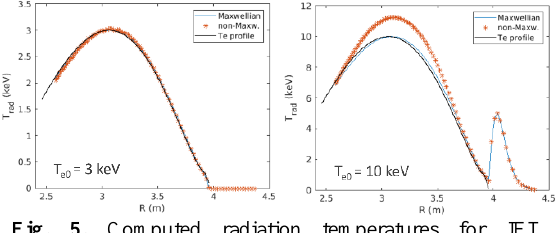
Fig. 5. Computed radiation temperatures for JET parameters and two different central temperatures. Assumed T e profile, Maxwellian distribution and perturbed distribution cases are shown. R is defined, for each frequency, as the cold resonance position. Perturbation parameters: f 0 = 0.03, p 0 /p th = 1,  /p th = 0.25.